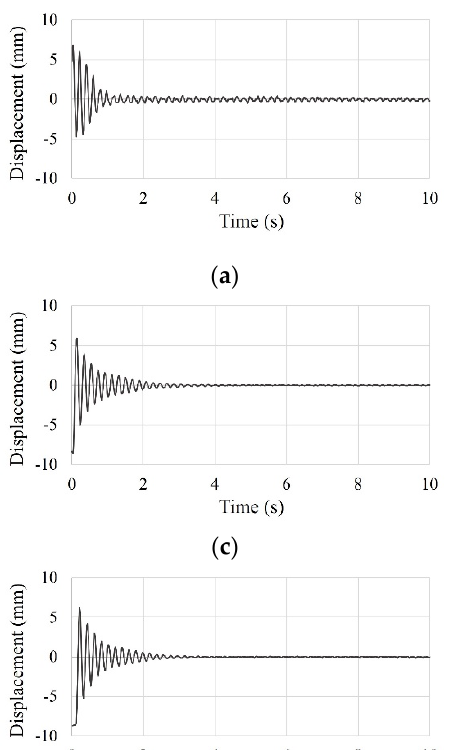
where ξ is the damping ratio, i and j is the number of cycles, u i is the peak amplitudes at the i-th